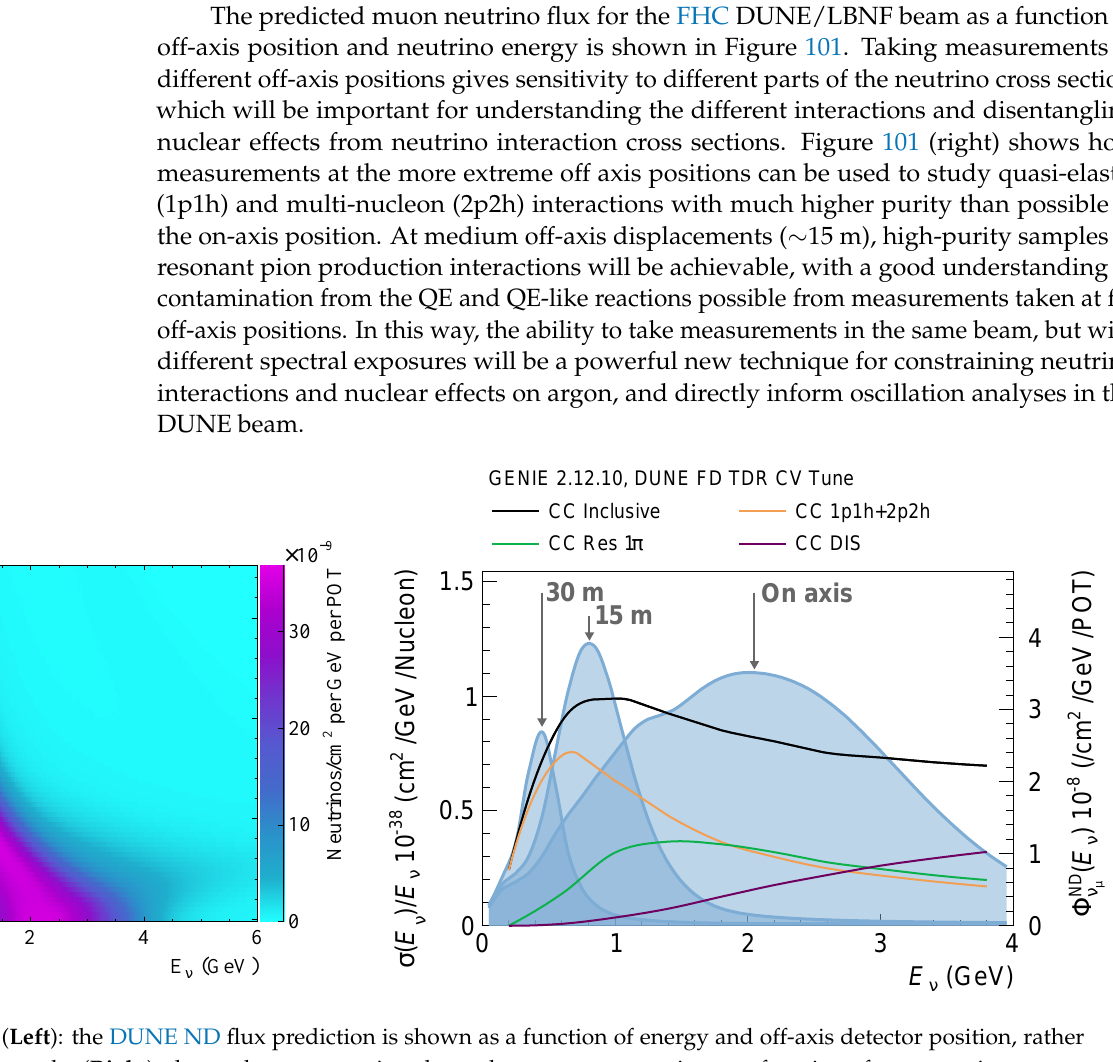
Figure 101. ( Left ): the DUNE ND flux prediction is shown as a function of energy and off-axis detector position, rather than off-axis angle. ( Right ): the total muon neutrino charged-current cross section as a function of true neutrino energy overlaid on a number of representative flux positions at different off axis displacements at the near site. The total is separated into contributions from elastic, and elastic-like (1p1h+2p2h), resonant pion production (Res 1 π ), and deep inelastic scattering (DIS) channels. Samples taken at different off axis positions will contain varying contributions from different interaction